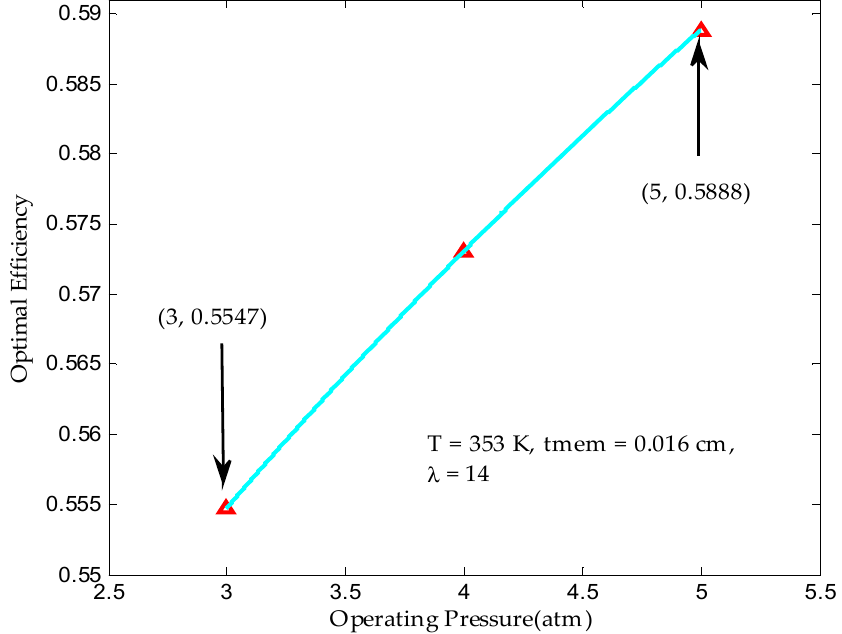
Figure 8. Optimal output efficiency varying with operating pressure.